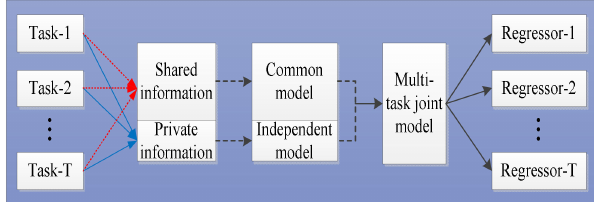
Figure 1. Block diagram of MTL-LS-SVR and